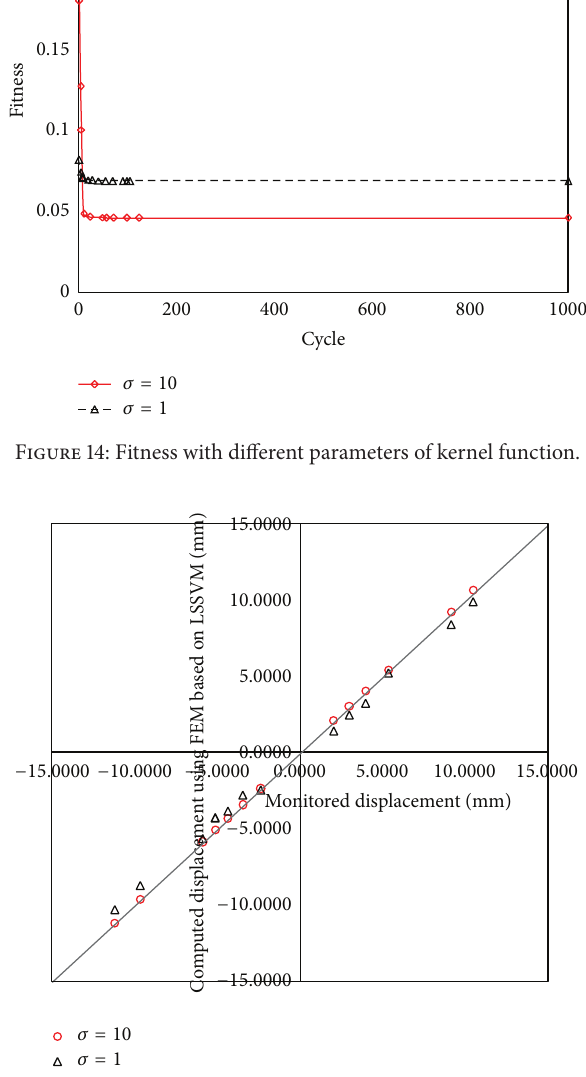
Figure 15: The performance of LSSVM with different parameters of kernel